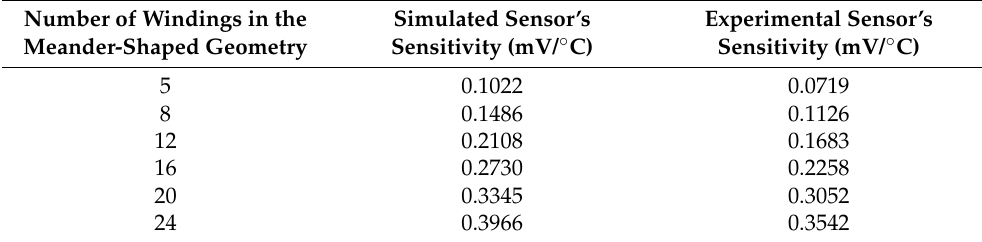
Figure 11. Comparative study of the sensors sensitivities obtained in the experimental results. Table 2. Sensor’s sensitivity of each sensor.